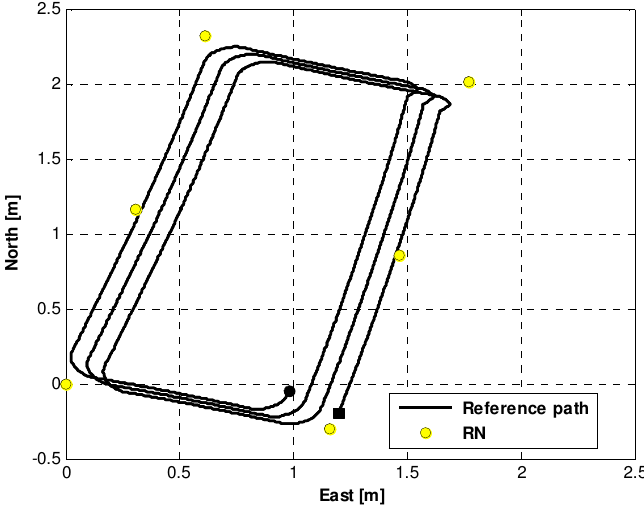
Figure 6. The trajectory of the real test.